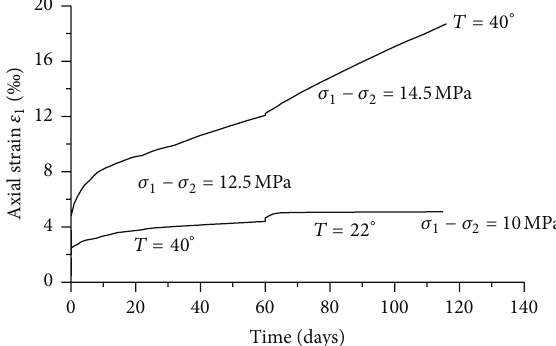
Figure 4: Typical stress-strain characteristics of rock salt in a cyclic uniaxial compression test [10].